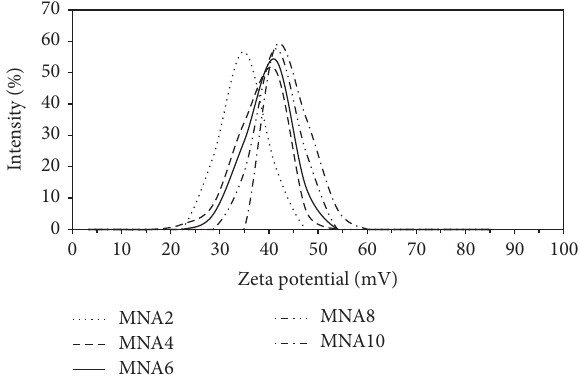
Figure 5: TGA thermograms of maghemite nanoparticles for all samples.